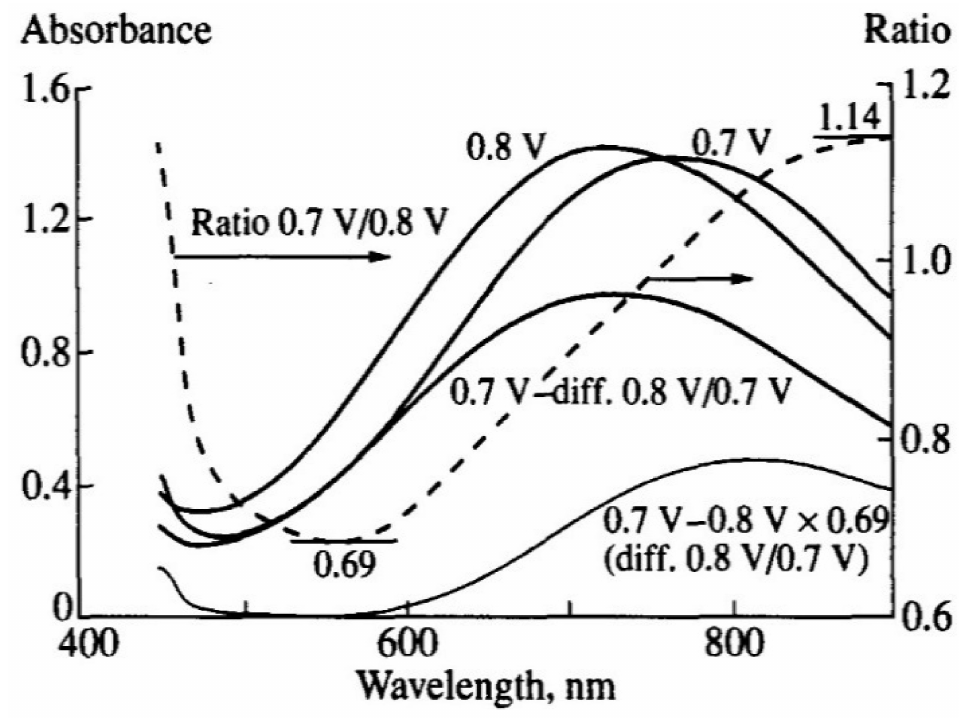
Figure 3. Demonstration of the principle of the Alentsev-Fok method for deconvolution of electron absorption spectra of PANI recorded in 1M aqueous HCl at 0.7 and 0.8V. Reprinted by